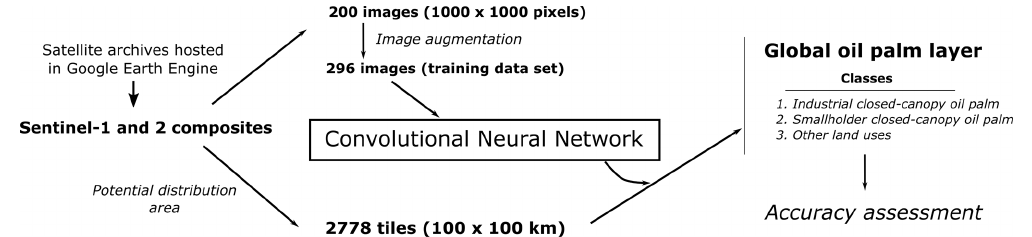
Figure 1. Diagram of the algorithm used to generate the global oil palm layer. The input images, Sentinel-1 and Sentinel-2 half-yearly composites, were obtained from Google Earth Engine on a grid of 100 × 100km. The Sentinel-1 and Sentinel-2 tiles were classified with a convolutional neural network (CNN). The CNN model was trained with labeled images with constant size (1000 × 1000 pixels). The output classification layer was validated with 13495 points that were randomly distributed.